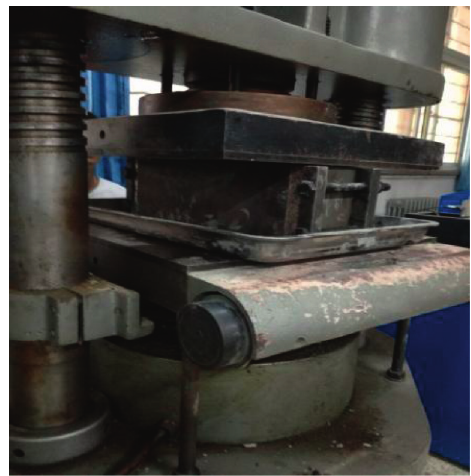
Figure 7: Production of dry shrinkage specimen.